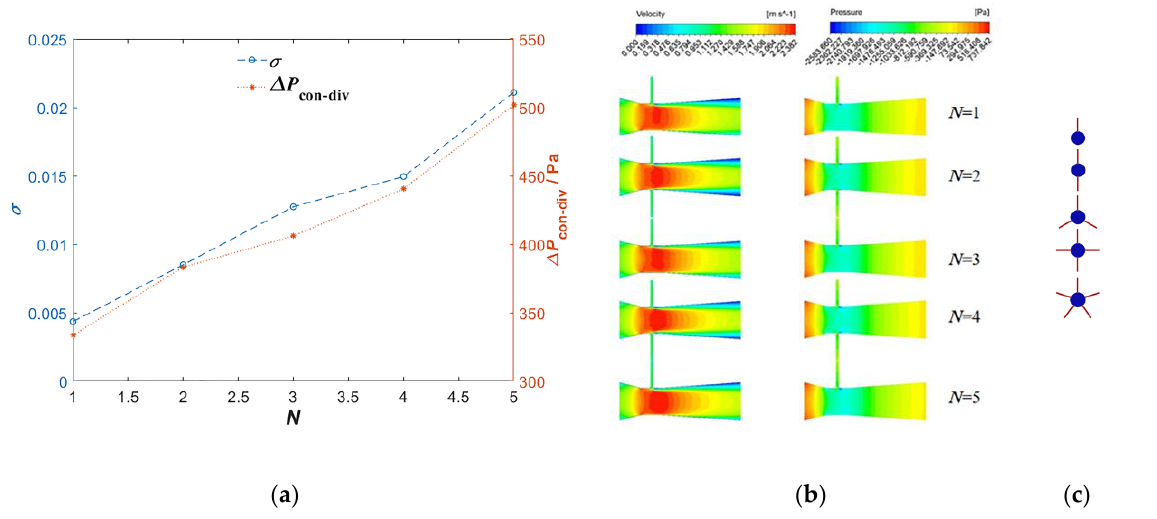
Figure 16. The effects of jetting tube number on the flow of ( a ) ∆ P con-div and σ, ( b ) velocity and pressure distributions in VTM and ( c ) the distribution of jetting streams.